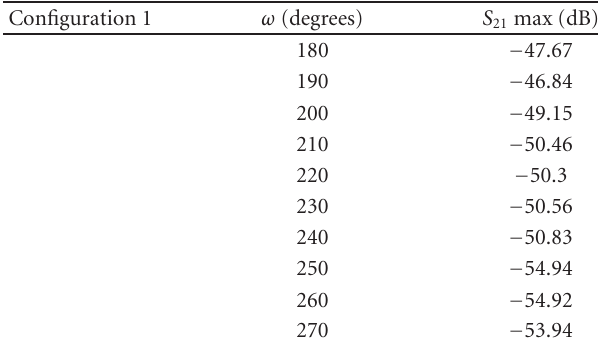
Figure 12: (a) Configuration for ω = 190 ◦ . (b) S 21 for ω = 190 ◦ . Table 2: S 21 variation for configuration